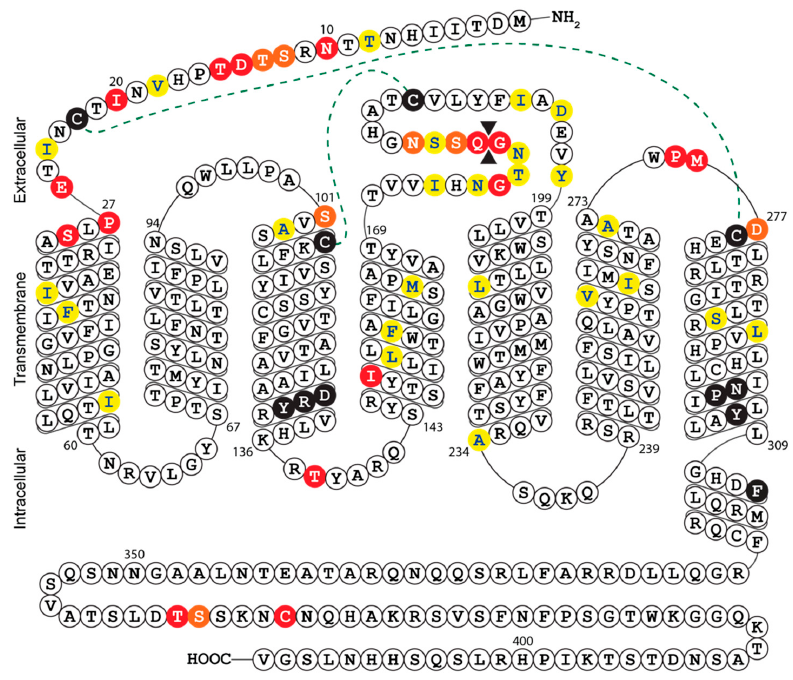
Figure 4. Snake-plot representation of the predicted secondary structure of HCMV Merlin UL33: Conserved residues in chemokine receptors are depicted by black circles and include the DRY motif in transmembrane helix (TM)-III and the NPxxYx (6) F motif in TM-VII. Disulfide bridges between cysteine residues in the N-terminus and TM-VII or TM-III and extracellular loop (ECL) II are represented by dotted lines. Amino acid sequence variability of the eight UL33 orthologs is indicated by colored circles; strongly similar properties (e.g. charge, hydrophobicity, and size) are depicted in yellow, weakly similar properties are in orange, and different properties are in red. An amino acid insertion between Gly 179 and Glu 180 is depicted by double black triangles. Complete amino acid sequences of the different strains can be found in Figure S2. Further research is necessary to explain apparent reported discrepancies regarding the role of UL33 in viral replication of HCMV and potential differences between HCMV strains. Although its single species tropism hampers in vivo characterization of HCMV dissemination, rodent CMVs are well studied in rodent infection models. MCMV- and RCMV-encoded orthologs of UL33, M33, and